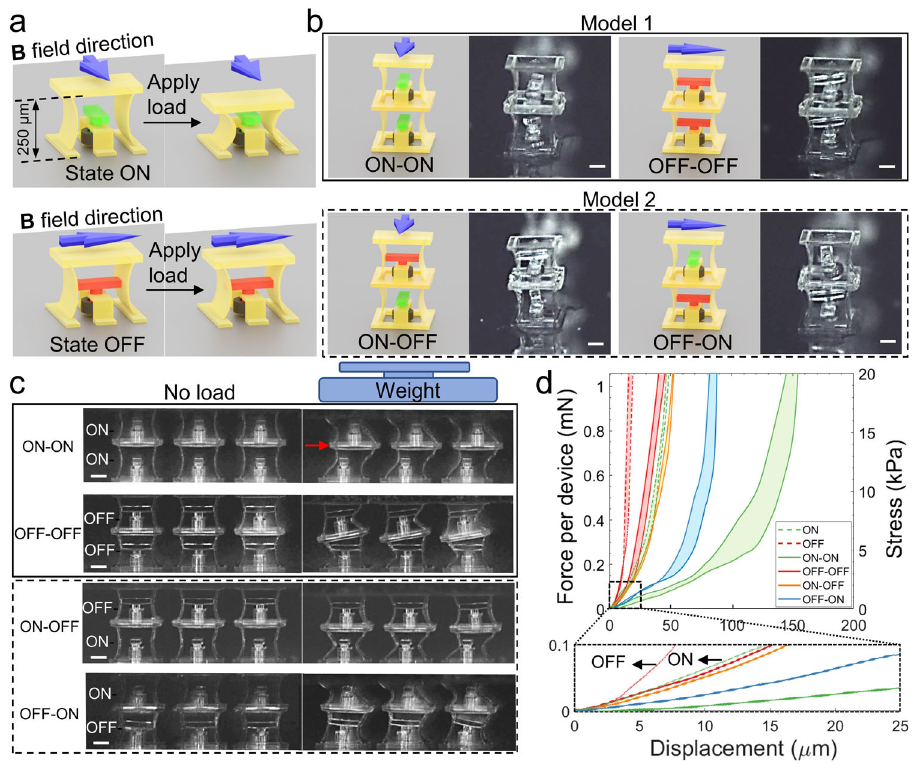
Fig. 5 Micro-mechanical-bits ( µ M-bits) as mechanical memory devices at the microscale enabled by DLW and micro-molding with a multiple-layer process. a Schematics showing the working mechanism and design of the µ M-bits. Blue arrows mark the B fi eld direction needed to align the stopper. b double-layer µ M-bits con fi gurations and the corresponding microscopic photo of each status. Scale bars: 100 µ m. c Video (Supplementary Movie 8) frames of the compressing progress of the double-layer µ M-bits under each state. Interlayers marked by red arrow have displacement in the shear direction. Scale bars: 100 µ m. d The force-displacement curves of both single-layer and double-layer µ M-bits. The force is measured from nine devices and averaged for plotting. The shaded area denotes the range of measured curves. Low displacement and low force region (dashed area) is zoomed in and the average curve of each sample is plotted for clarity. Table 1 Extracted modulus and spring constant of each µ M- bits design under both